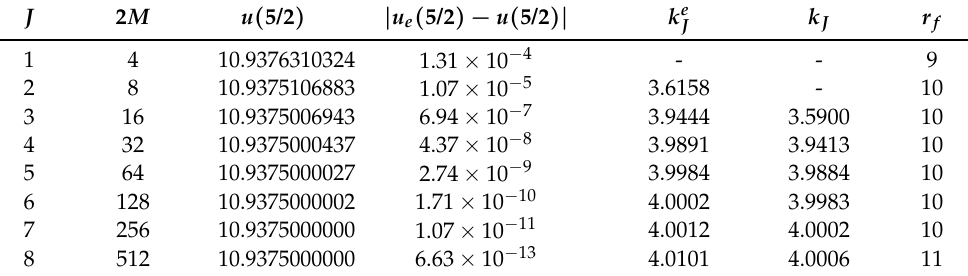
Table 6. Solutions to (19) where u e ( 5/2 ) = 10.9375 using HOHWM.